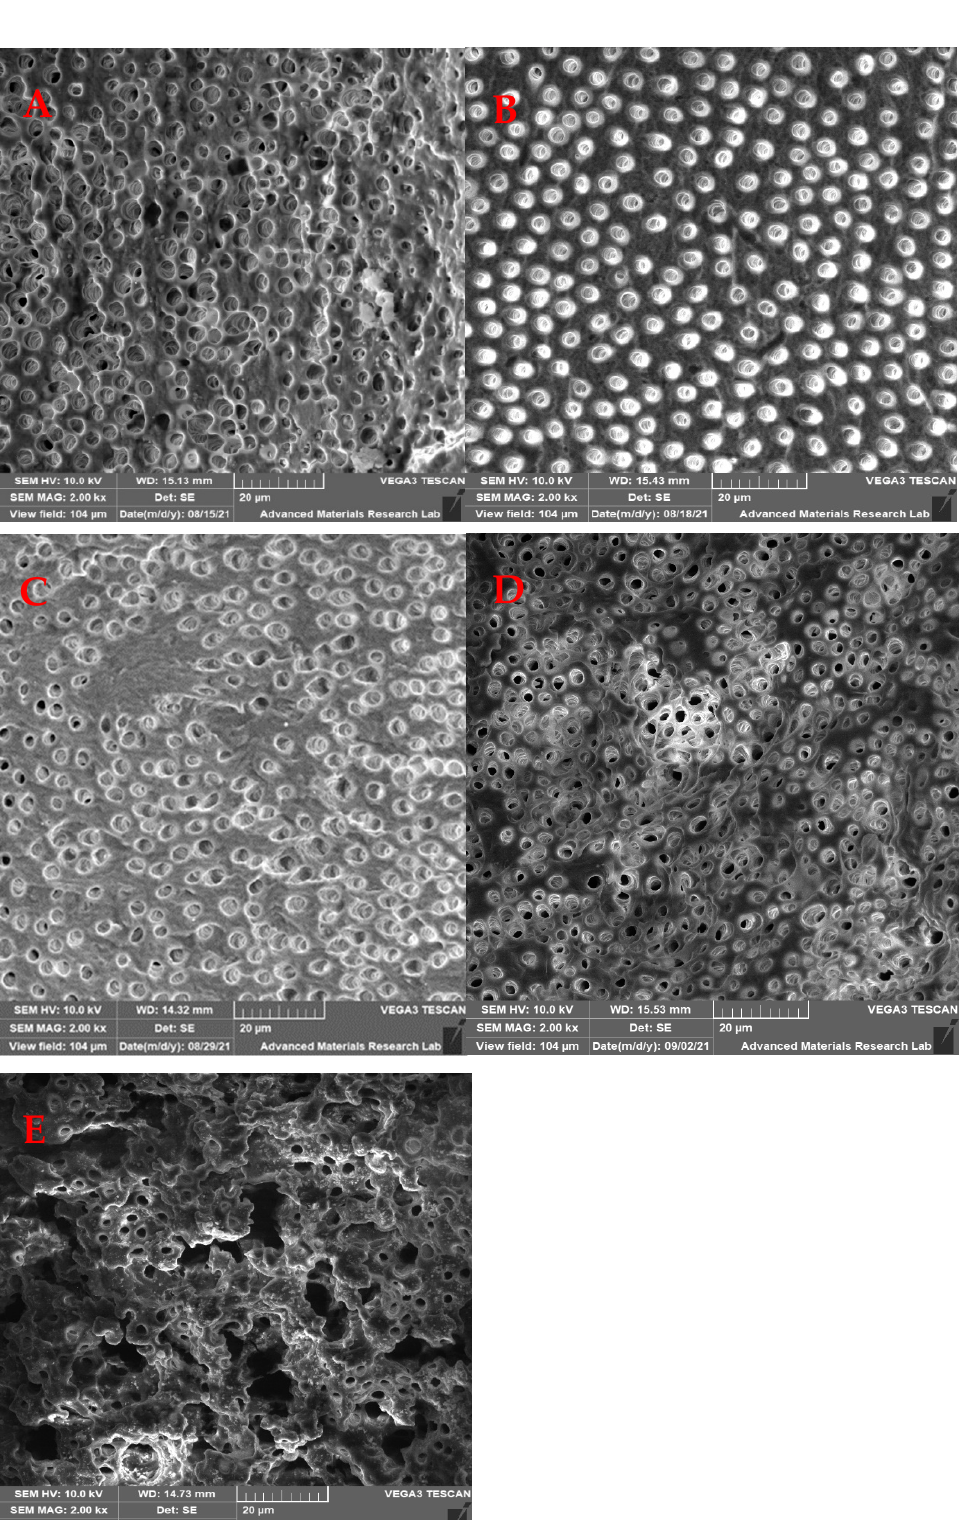
Figure 2. SEM photomicrograph (2000 × ) showing the remaining the smear layer at the apical third. ( A ) Ultrasonic group, ( B ) Laser 1 group, ( C ) Laser 2 group, ( D ) Laser 3 group, and ( E ) Laser 4 group.